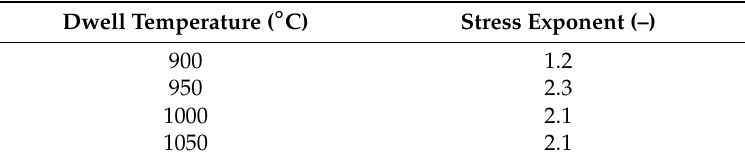
Table 1. Stress exponent values for Mg-doped alumina sintered in SPS under 50 MPa uniaxial pressure with various dwell temperatures. Dwell temperatures were reached within 2 min with consequently varying heating rates. A clear stress exponent change can be observed between 900 ◦ C and 950 ◦ C indicating a mechanism change from viscous flow towards grain boundary di ff usion controlled densification [54]. (reprinted with permission of Materials Research Society).